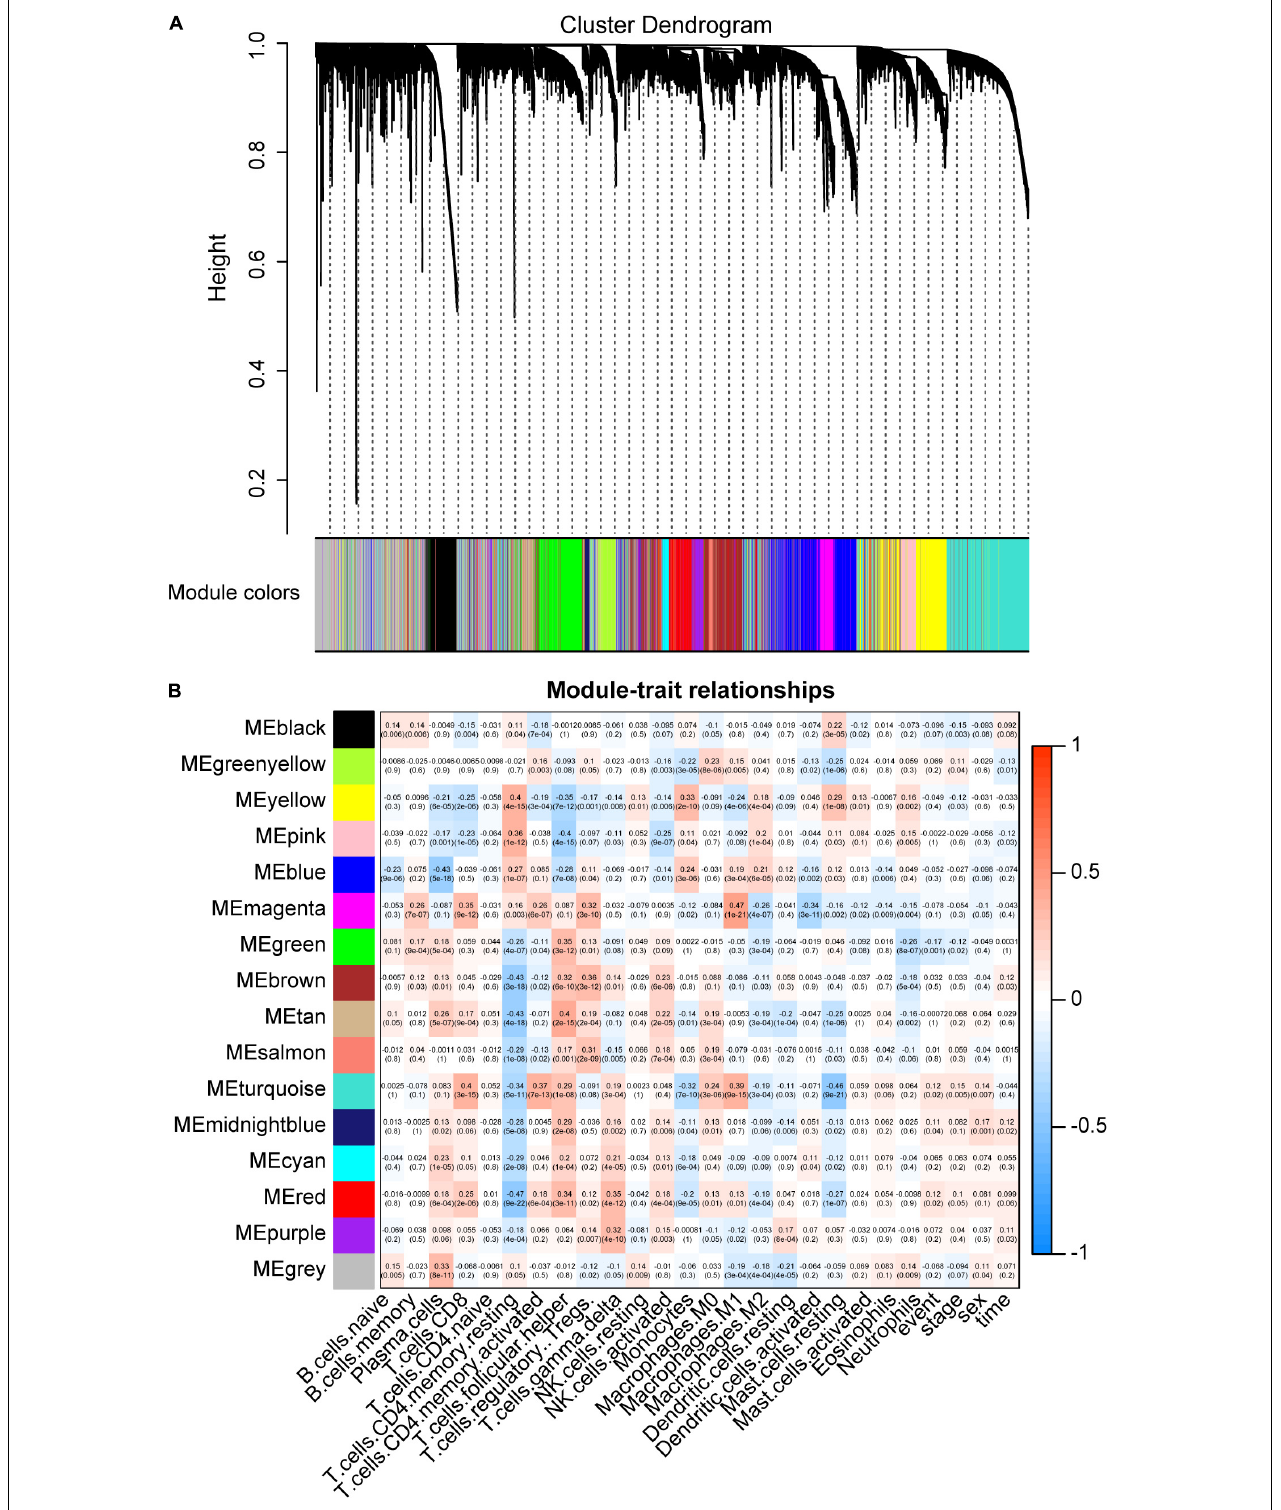
FIGURE 4 | Key modules and its correlation with CIBERSORT immune fractions. (A) Gene modules identified by hierarchical clustering. A total of 15 non-gray modules were generated. (B) The correlation between modules and CIBERSORT immune fractions. The turquoise module depicts the highest correlation ( r = 0.4, p = 3e-15) with CD8 T